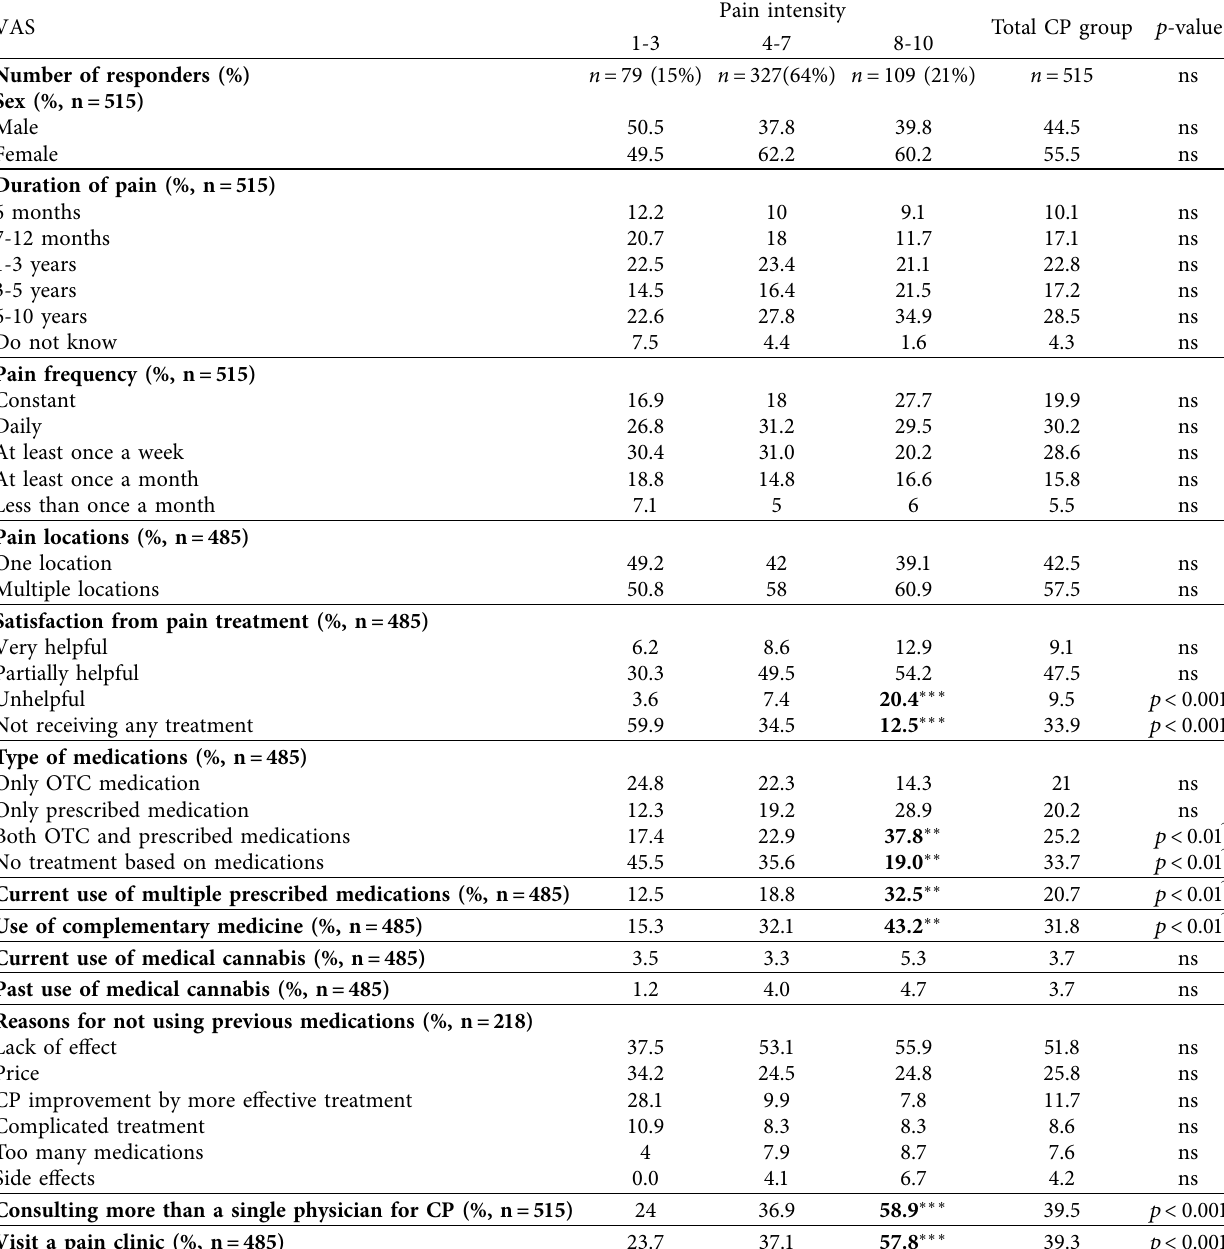
Table 2: Pain characteristics of three pain intensity